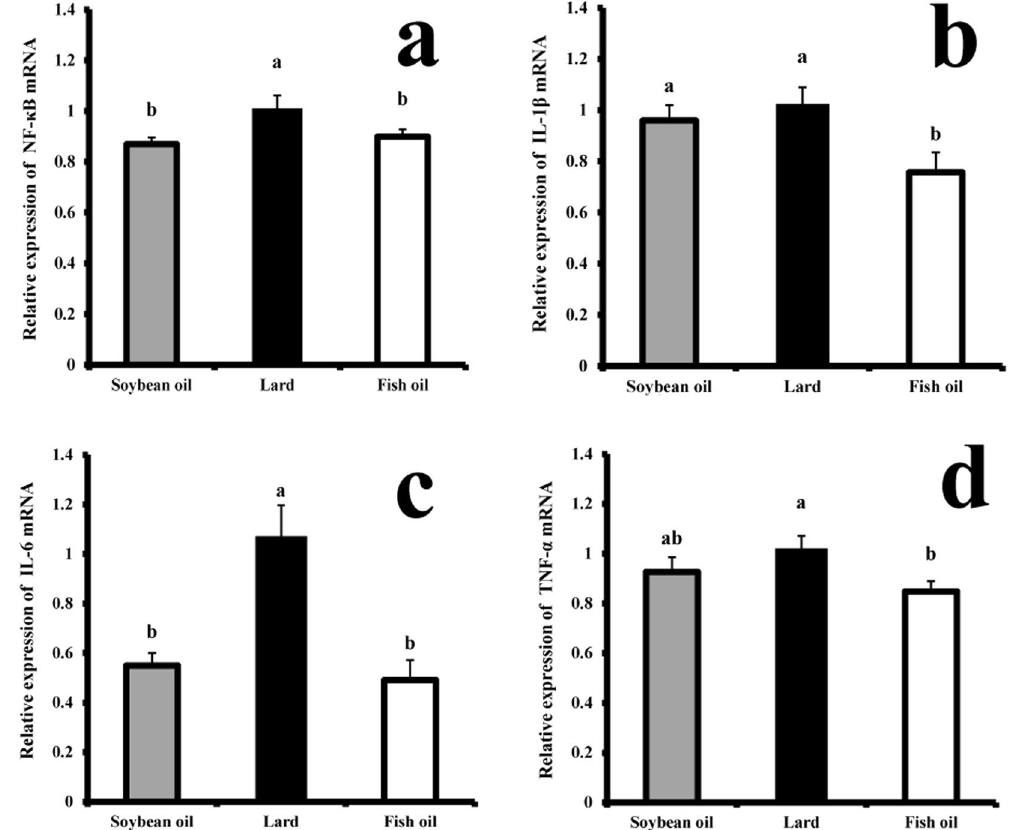
Figure 3. Hepatic mRNA levels of inflammatory cytokines of rats fed with soybean oil, lard and fish oil diets. ( a ) NF- κ B; ( b ) IL-1 β ; ( c ) IL-6; ( d ) TNF- α . The mRNA levels were determined by RT-PCR. Different letters indicate significant difference ( P <